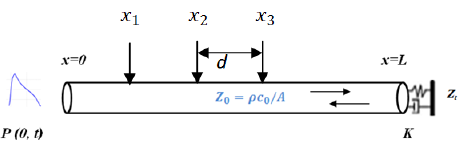
Fig. 1 Schematic diagram of a single vessel with length L